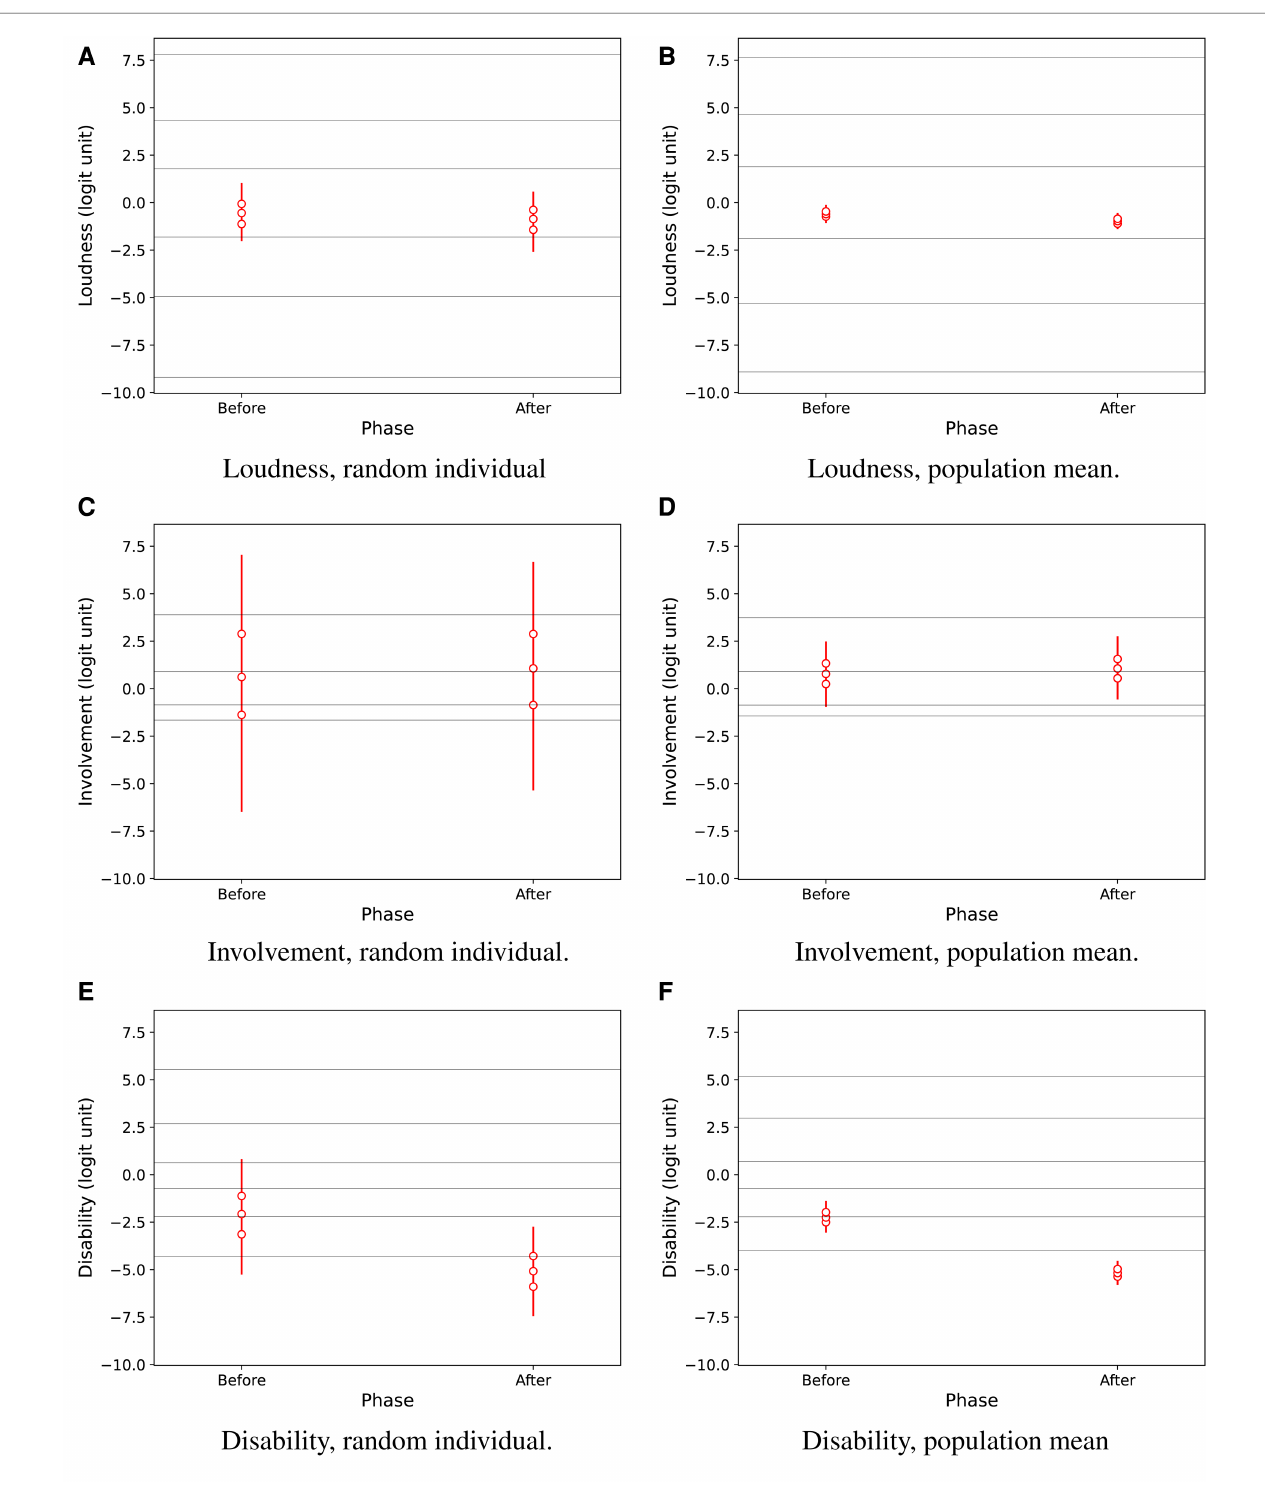
FIGURE 4 Predictive results for Loudness, Involvement, and Disability for a random individual in the population ( A , C , E ) and for the population mean ( B , D , F ), as estimated by regression as a function of the test phase, i.e., before and after hearing-aid fi tting. Vertical lines show 95% credible intervals for the marginal distributions of attribute values. Marker symbols show 25-, 50-, and 75-percentiles. Thin horizontal lines across the plots show median estimated response thresholds for the ordinal rating